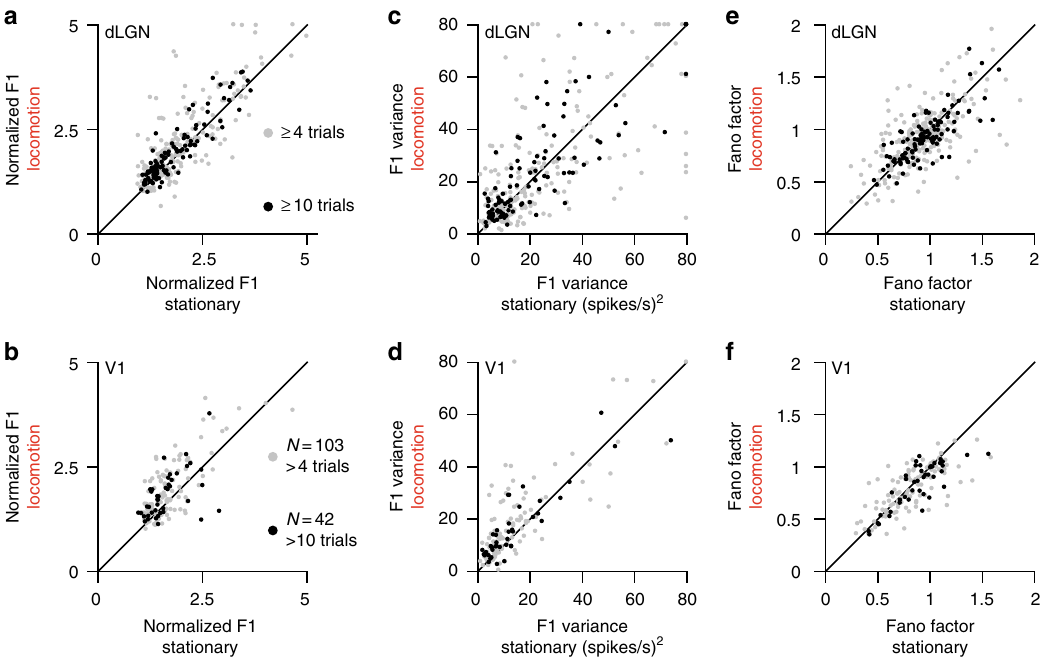
Fig. 4 Weak impact of locomotion on response variability. a Normalized F1 responses of dLGN neurons in locomotion vs. stationary epochs for cells with ≥ 4 (gray) or ≥ 10 locomotion trials (black) (TF experiments: n = 235 cells and 106/235 cells, respectively). b Same as a for V1 neurons ( n = 103 cells and 42/103 cells, respectively). c Trial-to-trial variance in F1 responses of dLGN neurons in locomotion vs. stationary trials (same cells as in a ). d Same as c for V1 neurons (same cells as in b ). e Fano-factor of fi ring rates responses in locomotion vs. stationary trials in dLGN (same cells as in a ). f Same as e for V1 neurons (same cells in b ). All measures are means computed across temporal frequency